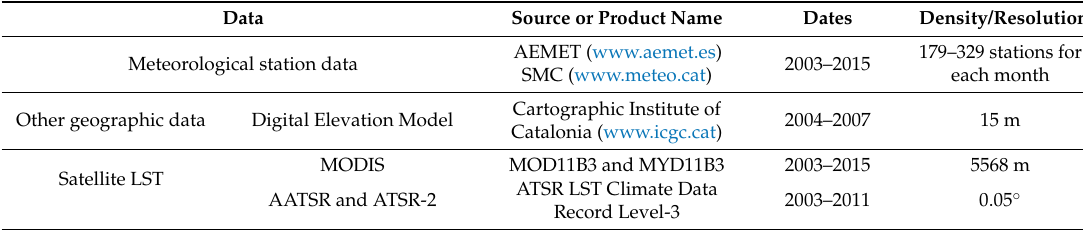
Table 1. Data used in the approach, together with its source or the name of the product, the date and the